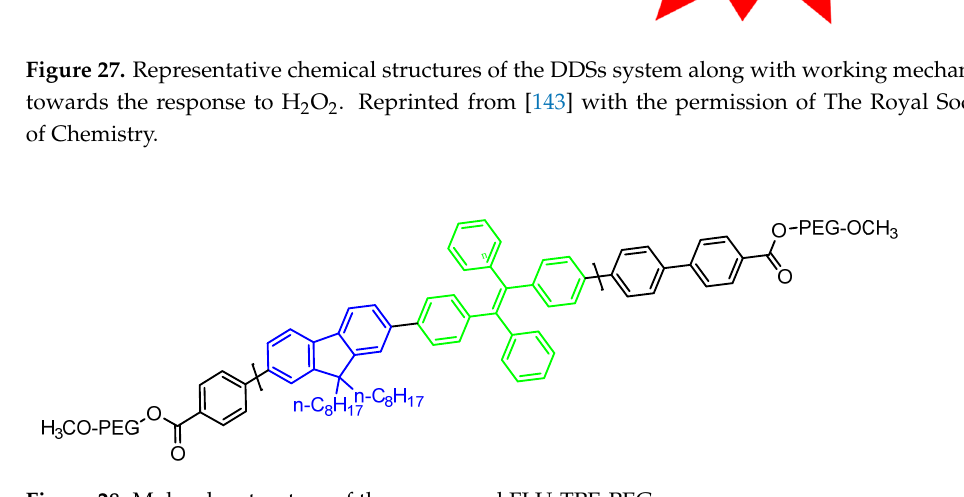
Figure 28. Molecular structure of the compound